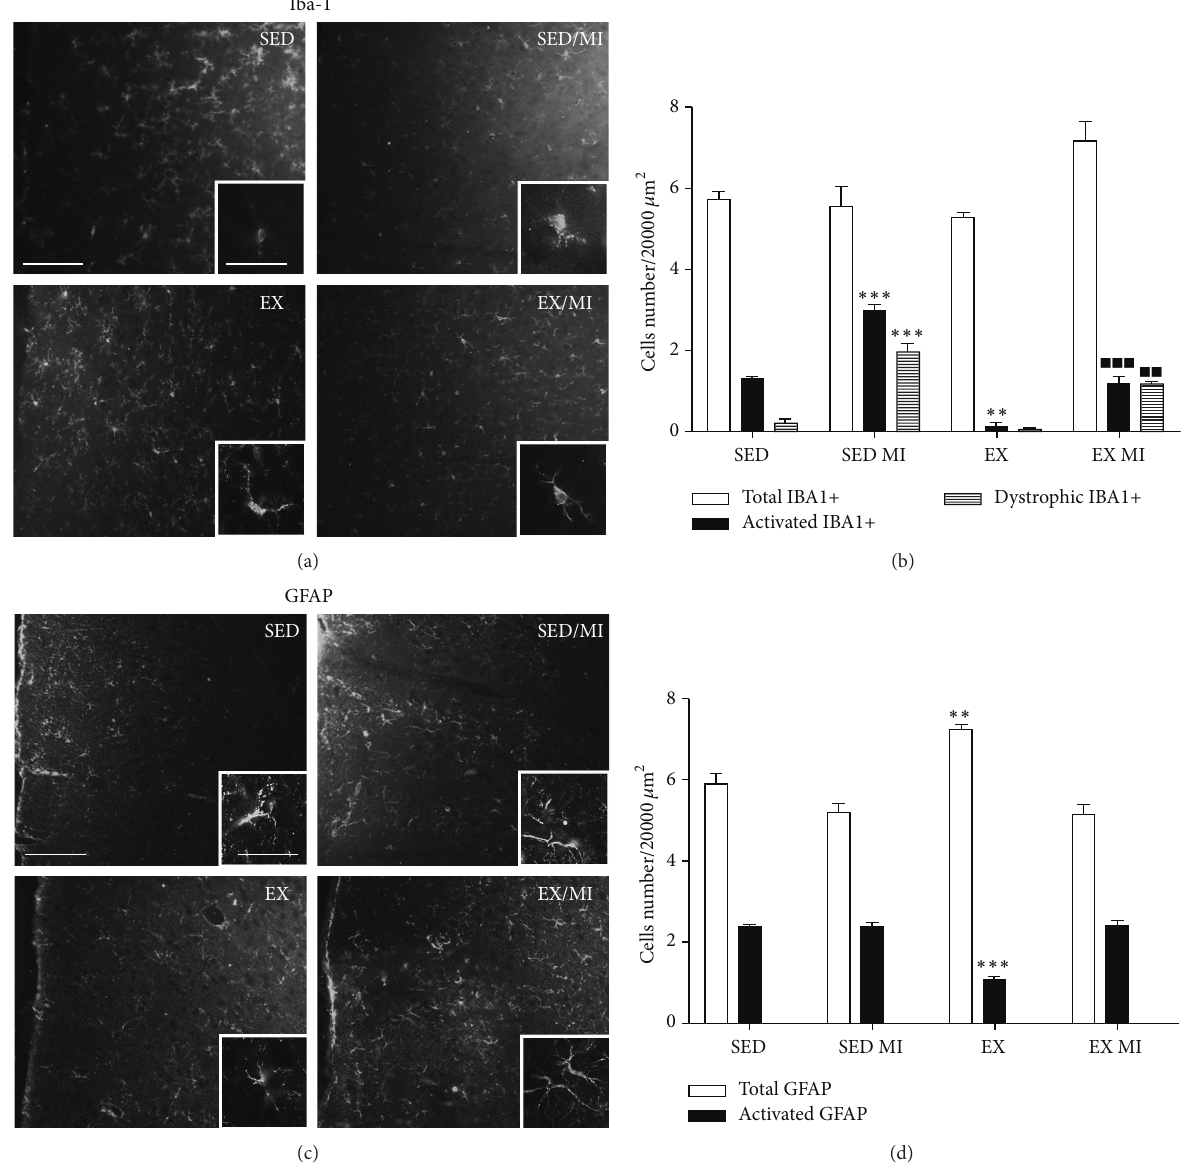
Figure2:EffectofprolongedexerciseonMIinducedmicrogliaandastrocytemorphologicalchangesintheprefrontalcortex.48 hMIinduced significant changes in hypertrophic (2 . 20 ± 0 . 32) and senescent (1 . 97 ± 0 . 2) (dystrophic-like) microglia in the prefrontal cortex as compared to the sedentary group without MI (1 . 29 ± 0 . 02 and 0 . 19 ± 0 . 12). Both phenotypes were significantly reduced by the prolonged exercise (1 . 16 ± 0 . 19 and 1 . 13 ± 0 . 07) (a, b). 48h MI did not modify the total (5.88 0.27) or reactive (2.36 0.05) astrocyte number in the prefrontal cortex, whereas exercise alone enhanced the resting/hypertrophic astrocyte ratio (7 . 25 ± 0 .09 and 1 ± 0 . 12) (c, d). Data are presented as mean ± SEM. ANOVA followed by Tukey post hoc test was used for statistical analysis. Three animals were used for each experimental group. ∗ 𝑃 < 0 . 05 , ∗∗ 𝑃 < 0 . 01, and ∗∗∗ 𝑃 < 0 . 001 versus sedentary group; z 𝑃 < 0 . 05, zz 𝑃 < 0 . 01, and zzz 𝑃 < 0 . 001 versus sedentary group with MI. Scale bars 100 and 25 𝜇 m for panoramic and inset image,